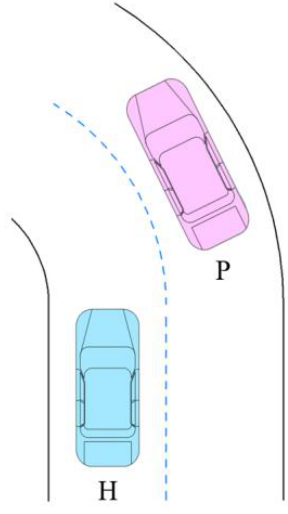
Figure 8. Curve scenarios. During the cut-in process of a nearby vehicle, similar to the lateral distance, the lateral speed of the nearby vehicle also gradually increases, and then gradually decreases until the cut-in maneuver is successful [26]. At the same time, in curve scenarios, a nearby vehicle also has a large lateral speed. Therefore, in order to avoid judging the turning behavior of a vehicle as a cut-in behavior, this paper uses the relative lateral speed between the host vehicle and the nearby vehicle as a reference.